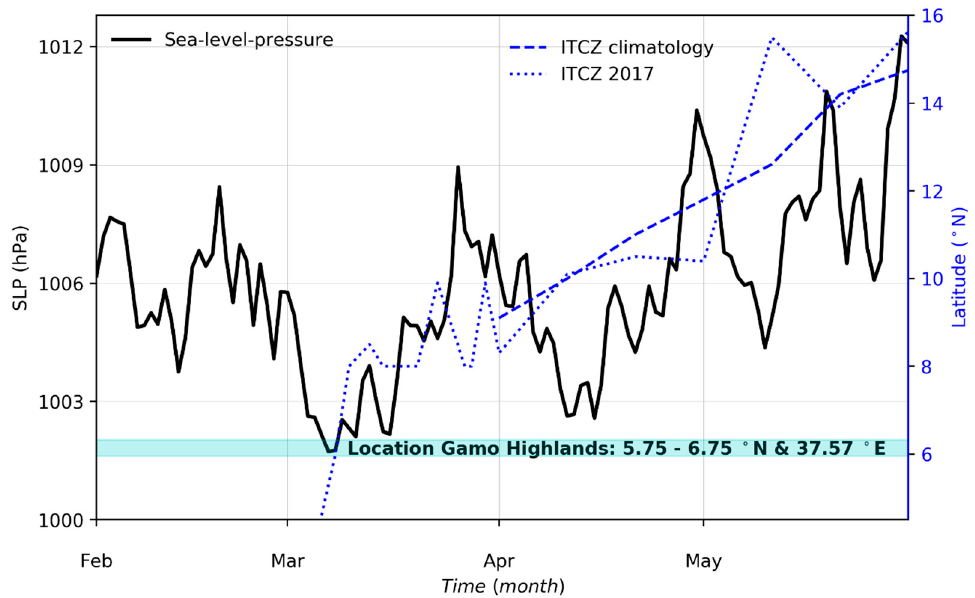
Figure 2. The daily mean observed SLP at Arba Minch station during the belg season of 2017. The SLP (black line with scale on the left y -axis); latitudinal variation of the ITCZ climatology (15-year data for April and May following Section 2.2) and in 2017 (blue lines with blue right-side y -axis). The ITCZ location data before March 2017 are not available. The cyan-coloured horizontal bar shows the latitude range of the Gamo Highlands.